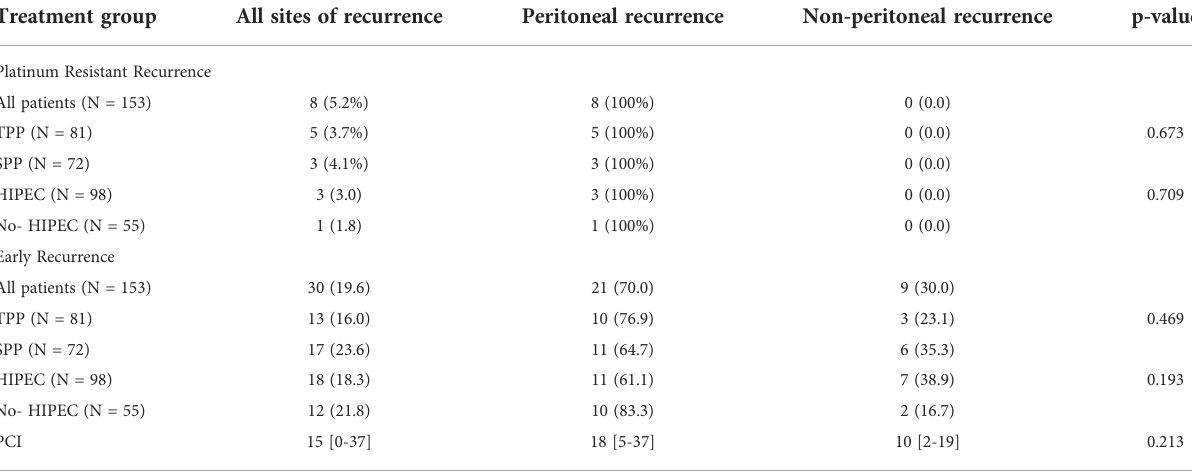
TABLE 9 Peritoneal and non-peritoneal recurrence in 8 patients that developed platinum resistant recurrence and 30 patients that developed early recurrence.